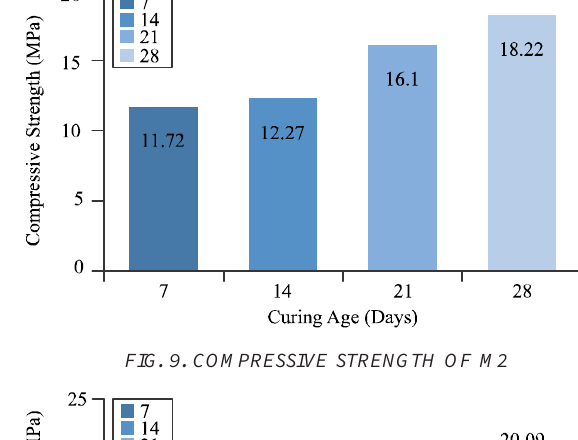
FIG. 9. COMPRESSIVE STRENGTH OF M2